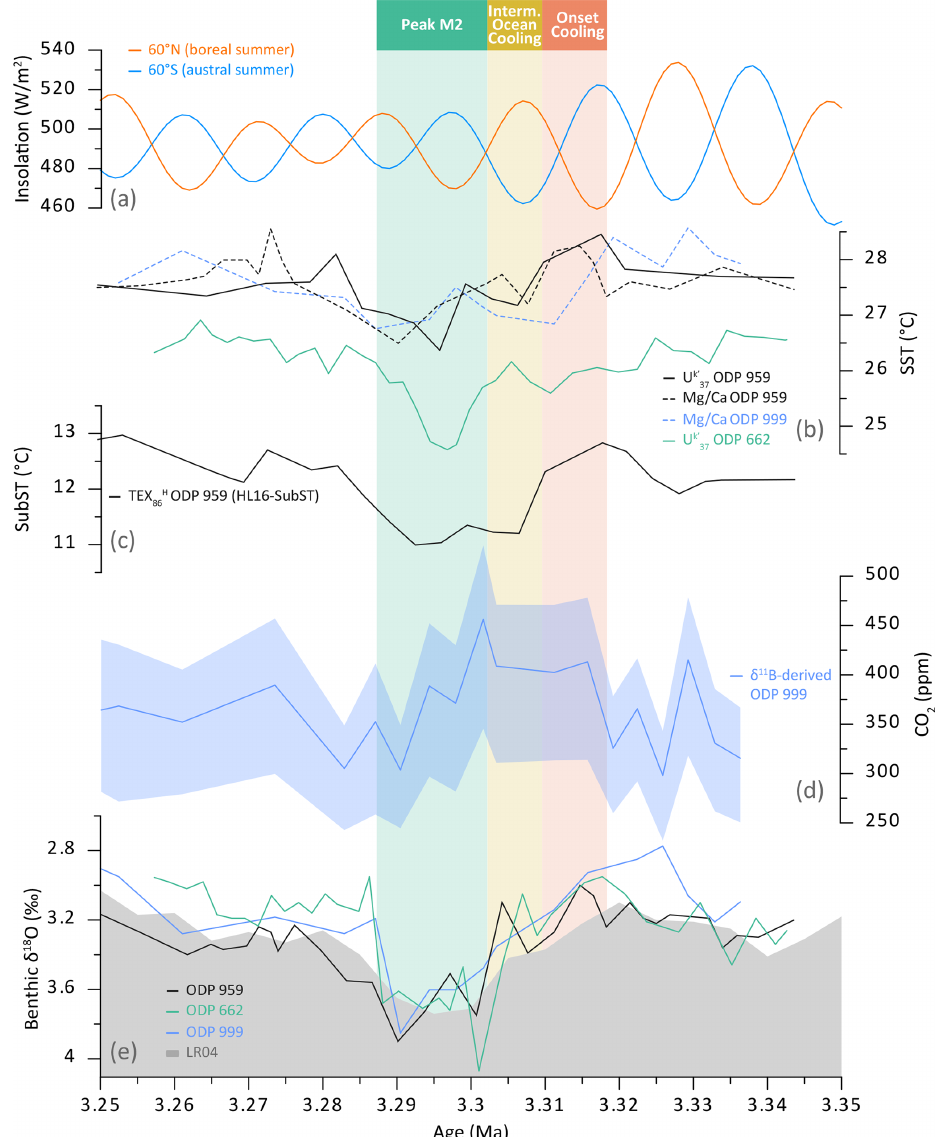
Figure 9. Exploring the chronology around the M2 glacial with records aligned on peak glacial benthic δ 18 O values (original age models in Fig. S2). (a) Daily insolation at 60 ◦ N/S during NH/SH summer solstice (Laskar, 1990). (b) East equatorial Atlantic SST at Site 959 (this study) and Site 662 (Herbert et al., 2010) and Caribbean Sea SST at Site 999 (de la Vega et al., 2020). (c) Site 959 TEX 86 HL16-SubST, indicative of intermediate ocean temperatures. (d) Atmospheric CO 2 reconstructions from Site 999 (de la Vega et al., 2020). (e) Benthic δ 18 O records of Sites 959 (van der Weijst et al., 2020), 662 (Lisiecki and Raymo, 2005) and 999 (Haug et al., 2001; de la Vega et al., 2020), aligned to LR04 (Lisiecki and Raymo, 2005) on peak M2